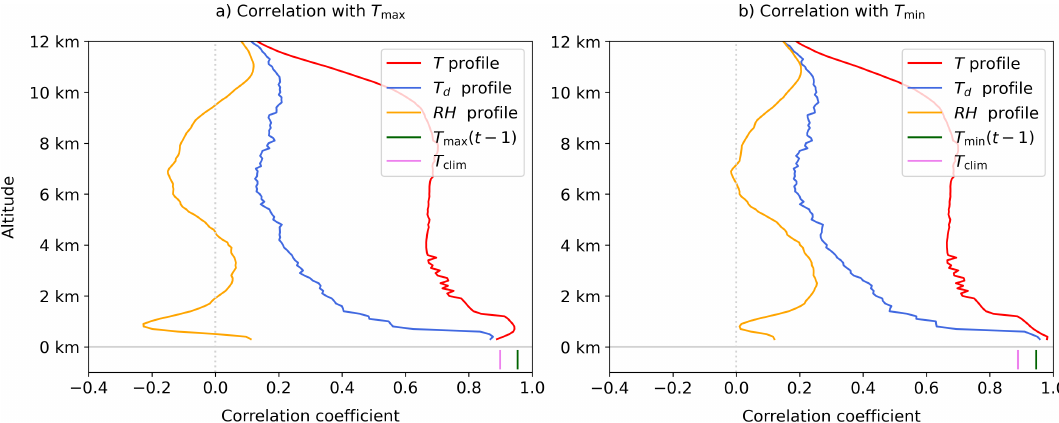
Figure 2. Correlations of temperature T , dew-point temperature T d and relative humidity RH profiles with ( a ) T max and ( b ) T min measured on the same day. The correlations with measurements from the previous-day ( T max ( t − 1 ) and T min ( t − 1 ) ) and climatological values ( T clim ) are also shown by short vertical lines in the lower part of the